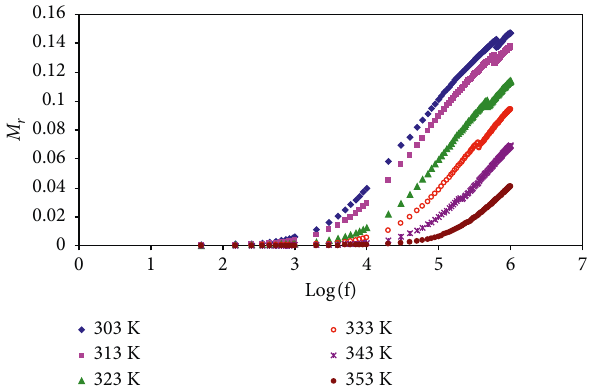
Figure 12: Real part ( M r ) of electric modulus versus frequency at selected temperatures for the PBS3 blend sample.